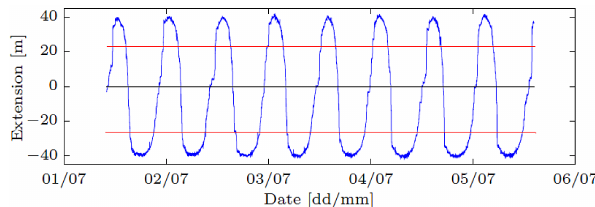
Figure 5. This graph shows the extension of buoy 18 in the dom- inant current direction (main principle component) related to the centre point. The maximal extension during ebb and flood are ap- proximately the